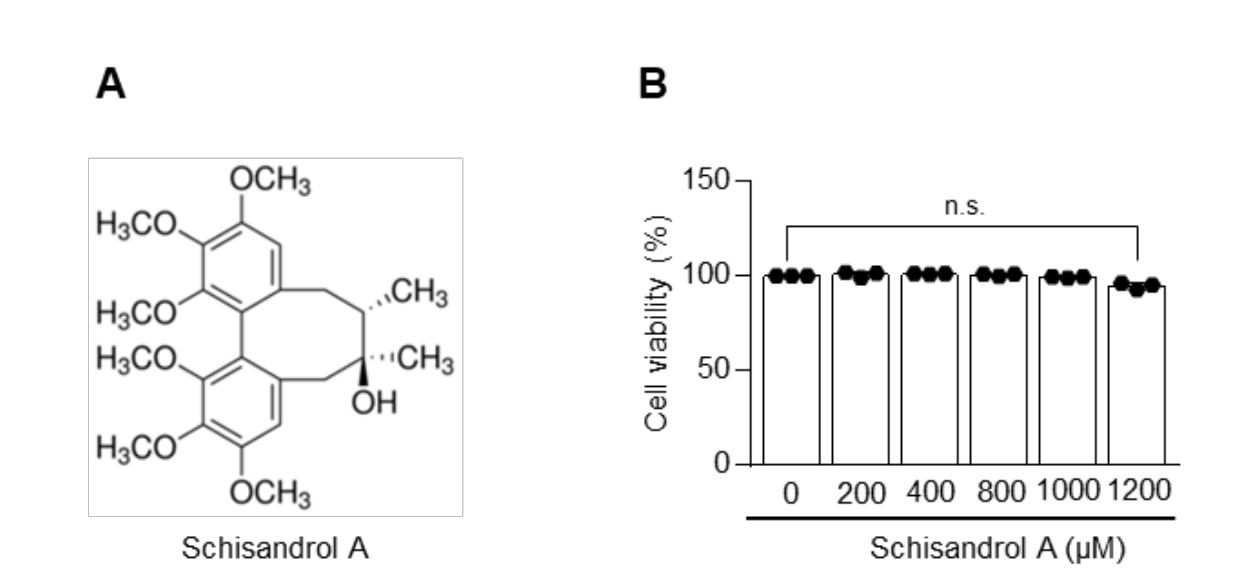
Figure 1. Toxicity of Schisandrol A toward chondrocytes. ( A ) Chemical structure of Schisandrol A. ( B ) Toxic effects of Schisandrol A on chondrocytes. Cell viability was measured at different concentrations for 24 h and analyzed using a lactate dehydrogenase (LDH) assay. Data were analyzed using one-way ANOVA with Bonferroni’s test, and plotted values were expressed as means ± SEM; n.s. p > 0.05, compared to the control group .